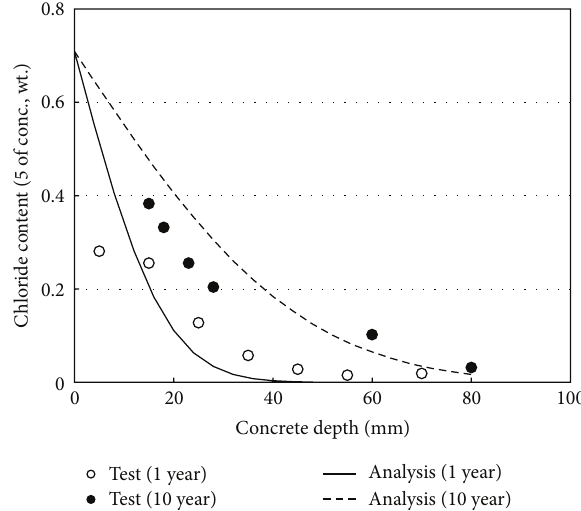
Figure 12: Chloride profile between results from field investigation and this study.